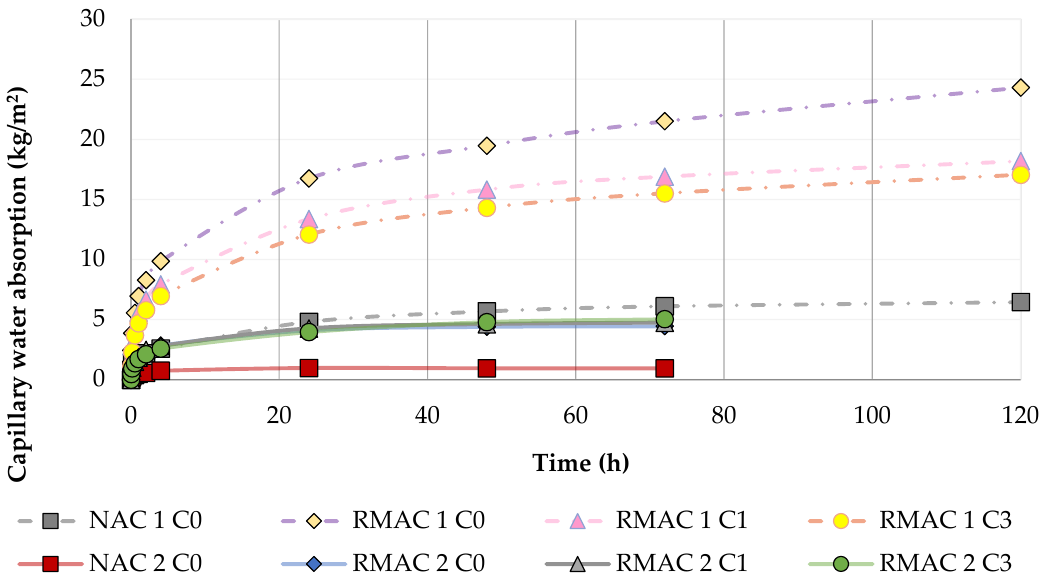
Figure 3. Comparison and progression of capillary water absorption of NAC and RMAC.